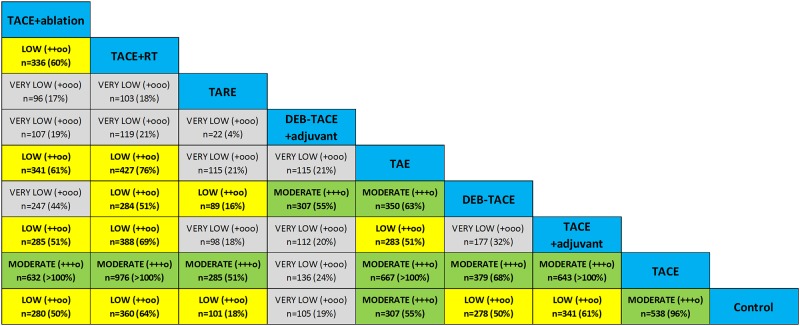
Strength and quality of evidence.QoE was graded as recommended for network meta-analyses on the basis of clinical diversity (between-trial heterogeneity of patient characteristics and/or study design), indirectness (absence of direct randomized comparisons), and imprecision (we chose a threshold of information fraction <50%). Effective sample size n for each comparison is shown along with information fraction (IF; %) in parentheses (compared to n = 560 for a hypothetical well-powered randomized study to detect a survival benefit of HR = 0.70 at 2 years). Color-coded representation of QoE; very low (light gray), low (yellow), moderate (green). There were no cases of high QoE observed.